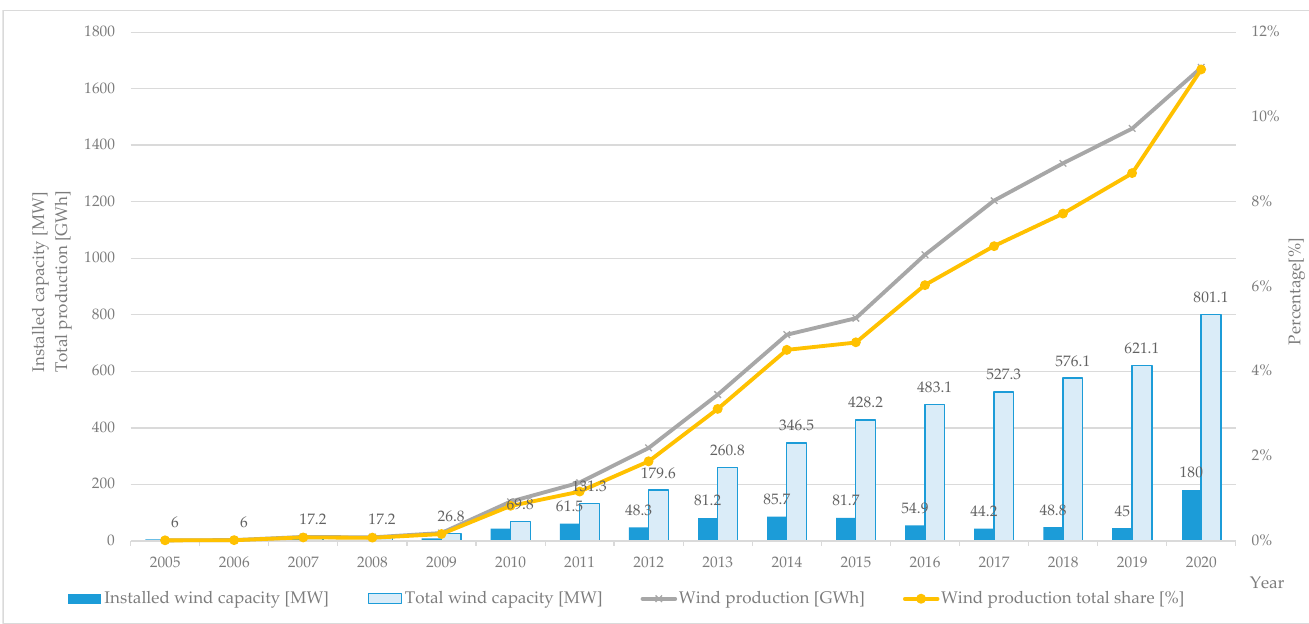
Figure 3. The integration level of wind power plants in the last 15 years—Croatian energy system.